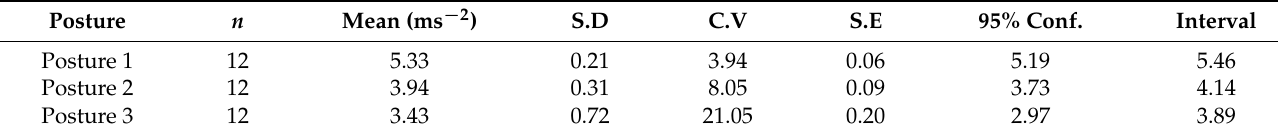
Table 2. Tool handle vibration (ms − 2 ) test results statistics.